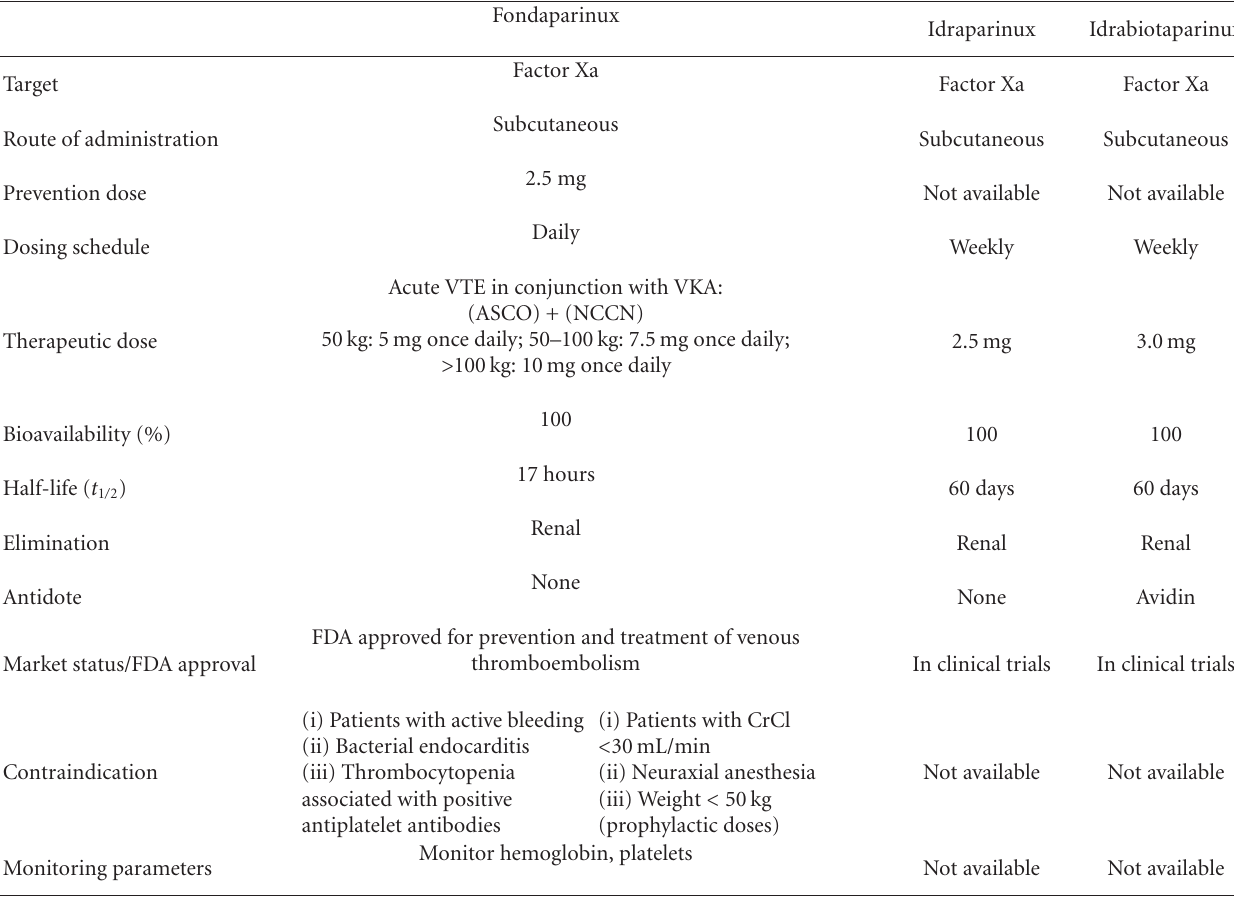
Table 2: Injectable factor Xa inhibitors [17,